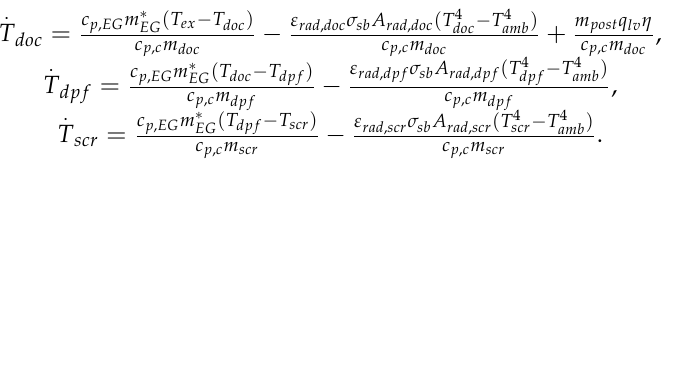
Figure 5. Verification result of the engine model under transient operating conditions: ( 1 ) engine speed, ( 2 ) air intake mass, ( 3 ) engine torque, ( 4 ) fuel consumption of engine.